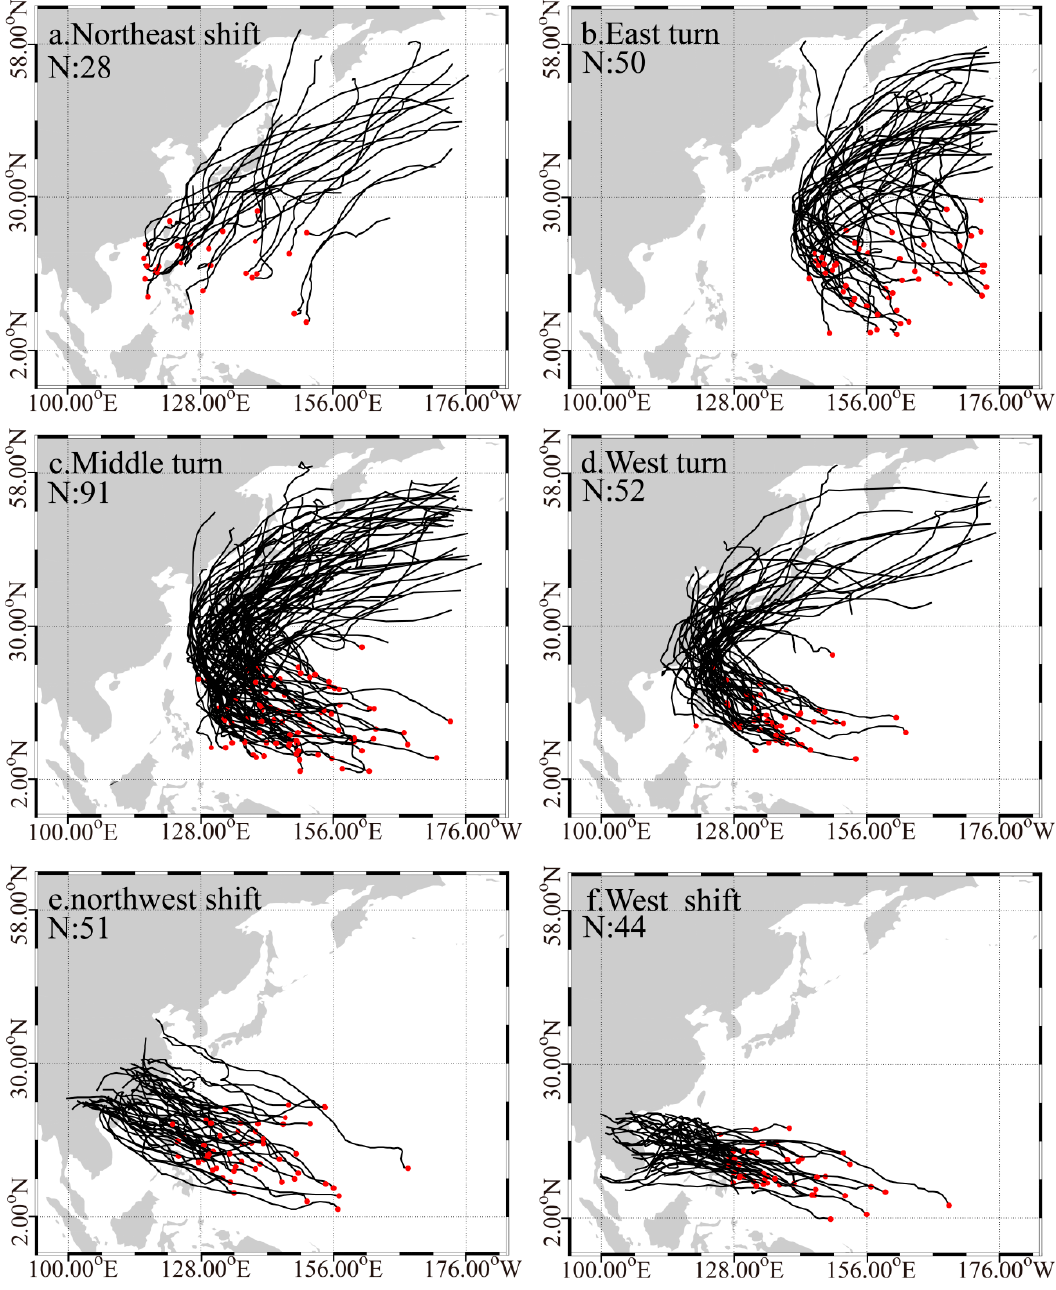
Figure 3. The six types of collected typhoon tracks from the JMA track data, in which the red spots represent the typhoons. ( a ) Northeast shift; ( b ) east turn; ( c ) middle turn; ( d ) west turn; ( e ) northwest shift; and ( f ) west